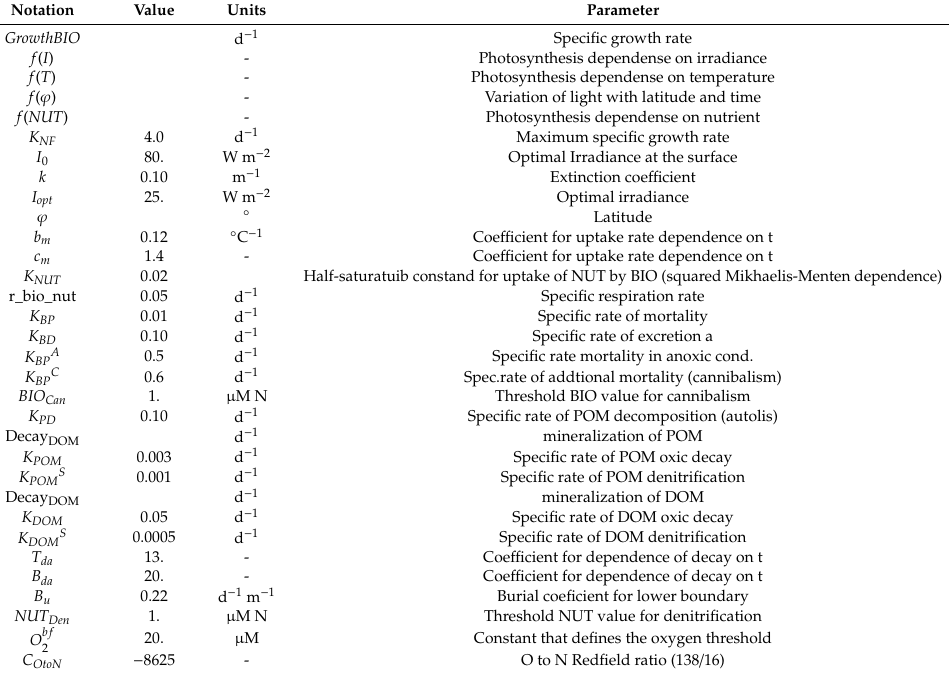
Table A1. Notations, values, units and names of parameters used in